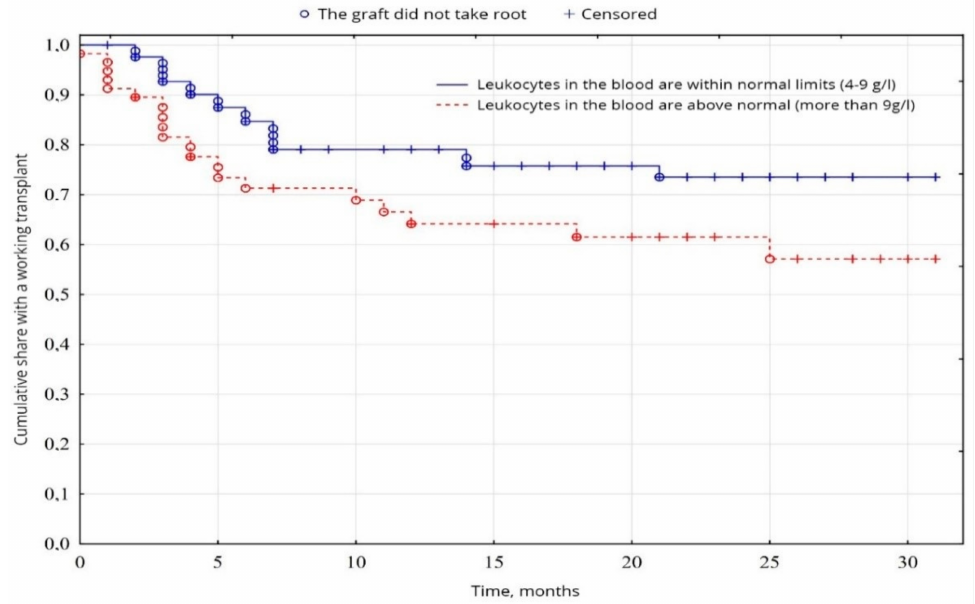
Figure 4. Evaluation of graft function depending on leukocytosis in the blood.